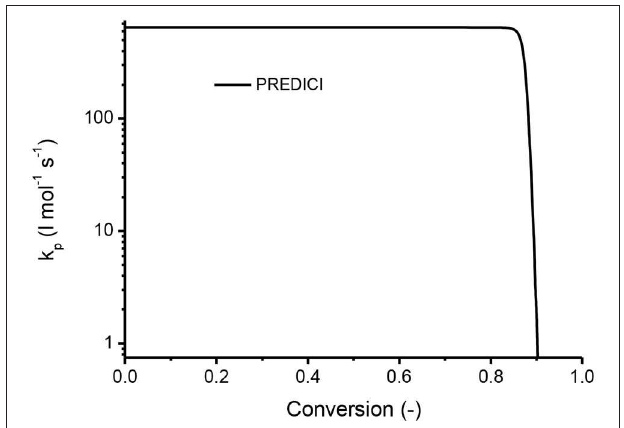
FIGURE 5 | Typical PREDICI simulation of the conversion of the initiators Perkadox 16 (blue points), Laurox (orange points), Trigonox 141 (gray points), the monomer methyl methacrylate (MMA) (yellow points), and the temperature (isothermal 110 ◦ C) (blue line).